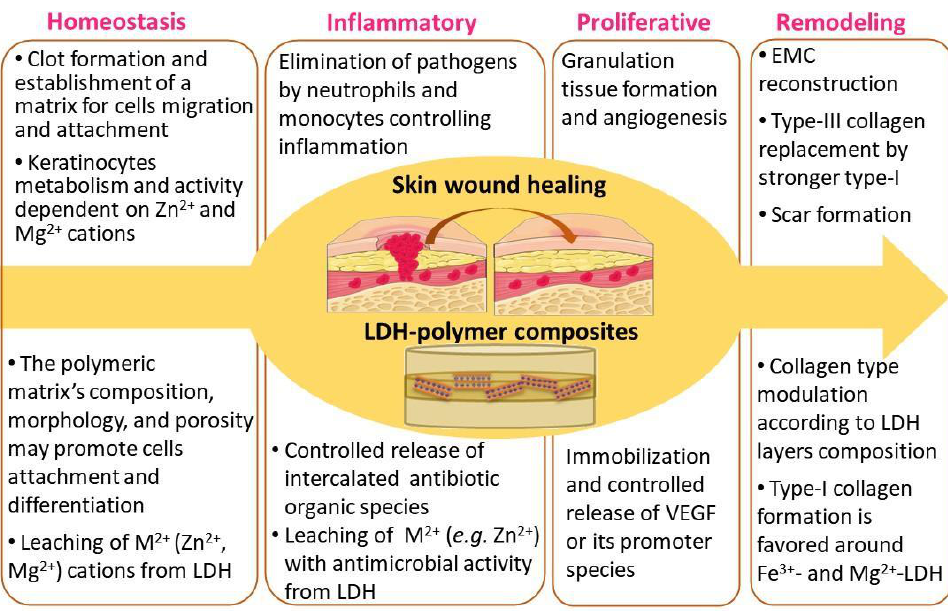
Figure 17. Progression of wound healing: some characteristics of each step of wound healing (top description) and the corresponding possible contribution of polymeric matrices and LDH (bottom description).